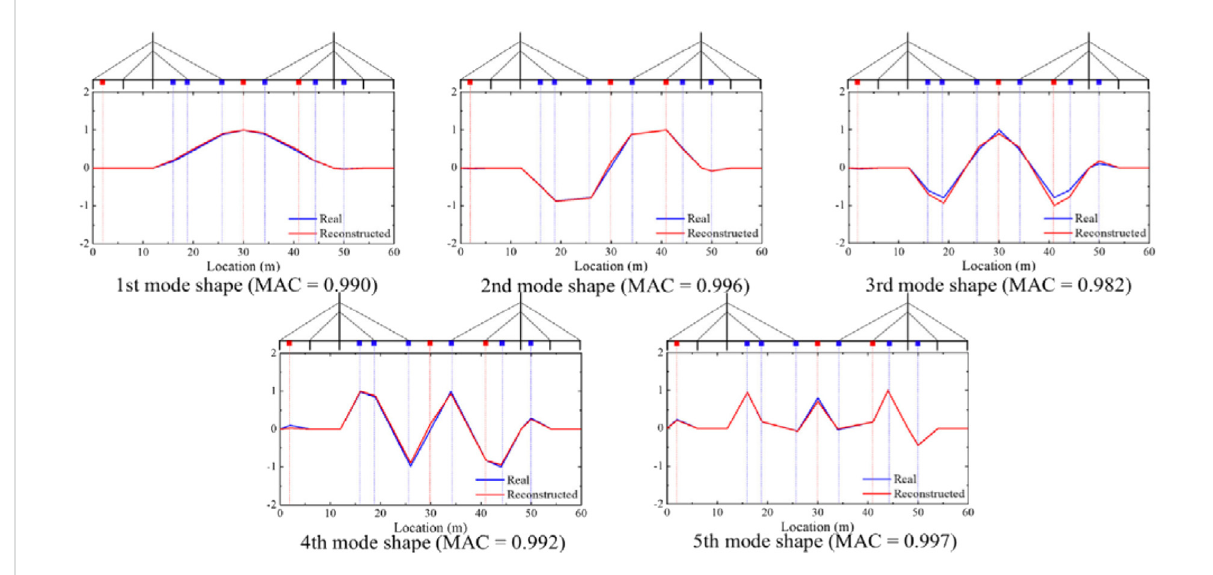
FIGURE 10 Comparison between the mode shapes extracted from the real and reconstructed signals (Lei et al., 2021).